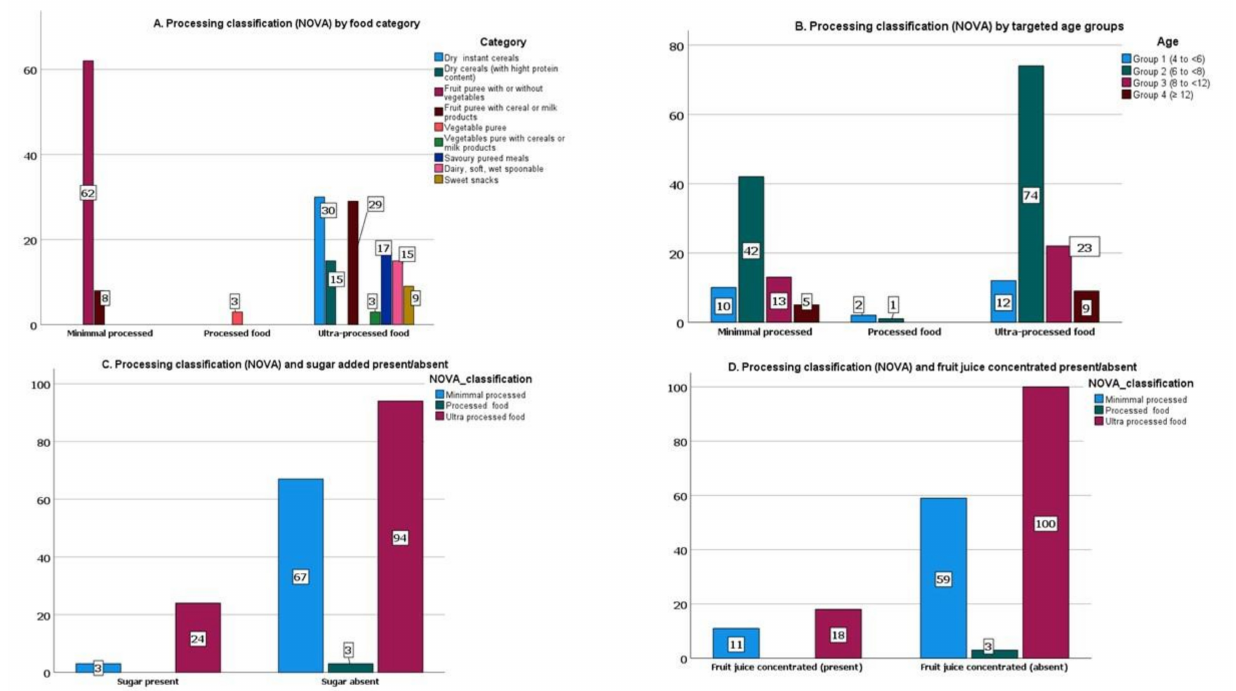
Figure 4. ( A ) Processing classification (NOVA) by food category ( n ); ( B ) processing classification (NOVA) by targeted age groups ( n ); ( C ) processing classification (NOVA) and added sugars (sugar) (present/absent) in the ingredient list ( n ); ( D ) processing classification (NOVA) and added sugars (fruit juice concentrated) (present/absent) in the ingredient list ( n